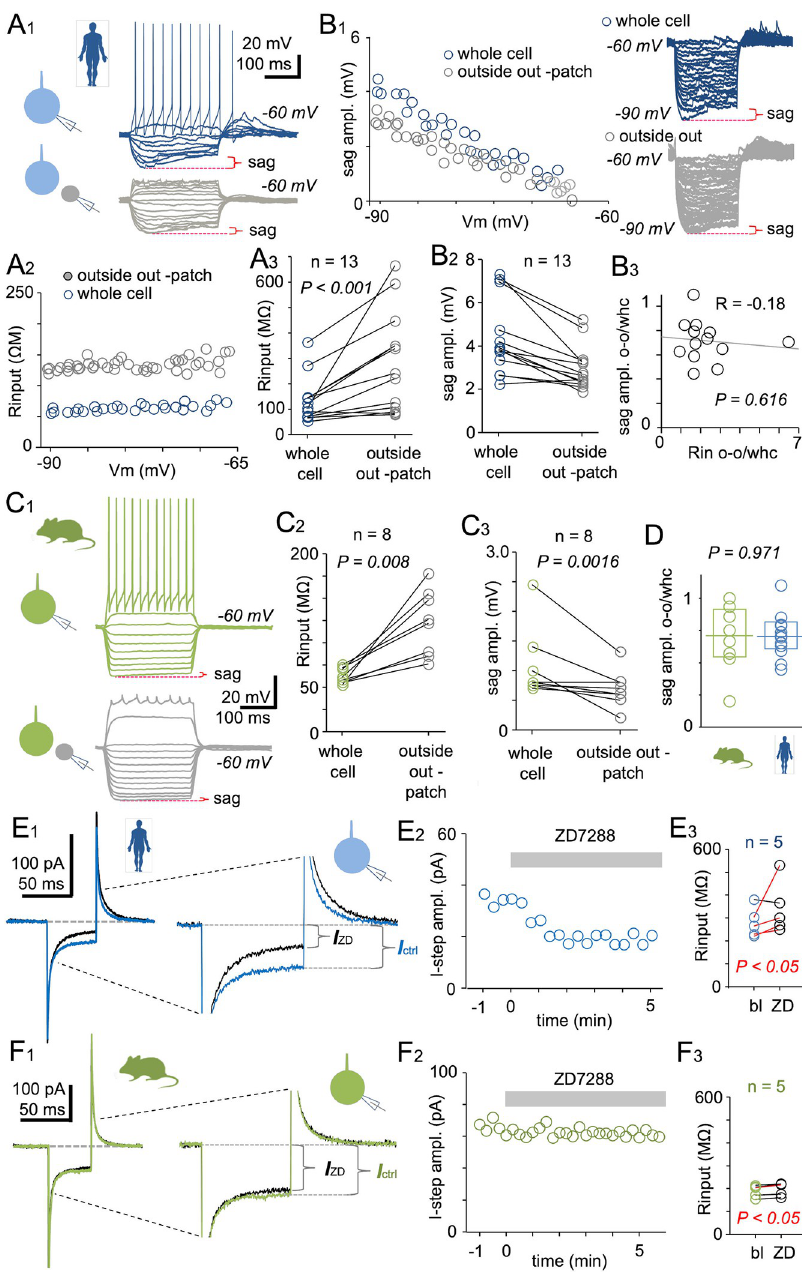
Fig 4. Evidence for stronger HCN channel activity at the somatic compartment of human fast-spiking interneurons compared to mouse fast-spiking interneurons from outside-out patch recordings. ( A ) Outside-out patch recordings obtained from human fast-spiking cell somata. ( A1 ) First, the sag potential was measured in somatic whole-cell clamp mode (blue traces) by applying hyperpolarizing current steps from − 60 mV. Sag potential amplitude during a voltage step to − 90 mV is indicated by the red marking. Next, outside-out nucleated patches were established by pulling out the pipette. Gray traces show membrane potential changes from current steps applied to the same cell but in the somatic outside-out patch configuration. Schematic insets on left show the experimental design. ( A2 ) Input resistance (ordinate) of the same cell measured by membrane potential steps to hyperpolarized potentials (abscissa) from − 60 mV in the somatic whole-cell clamp mode (blue symbols) and outside-out patch configuration (gray symbols). ( A3 ) Input resistance in 13 fast-spiking human basket cells measured by hyperpolarizing step to − 90 mV from − 60 mV in whole-cell clamp mode (blue symbols) and the outside-out patch configuration (gray symbols) ( P < 0.001 by Wilcoxon signed-rank test). ( B ) Sag amplitude is largely preserved in human fast-spiking cell somatic outside-out recordings. ( B1 ) Sag amplitude (ordinate) in one fast-spiking cell measured during membrane